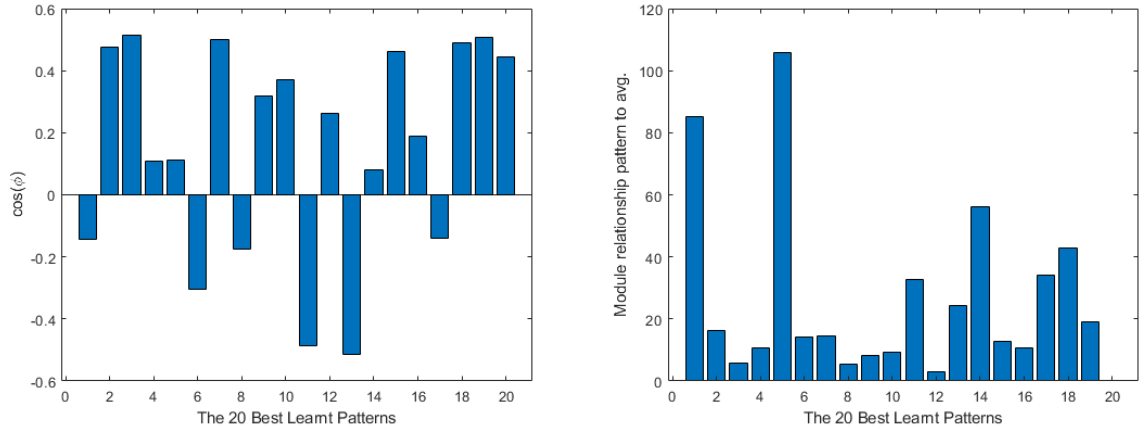
(cid:12) (cid:12) 𝜕𝐿𝑜𝑠𝑠 ∂ Loss (cid:12) (cid:12) | relationship to the average (cid:12) (cid:12) relationship to the average ∂ W n 𝜕𝑊 𝑛